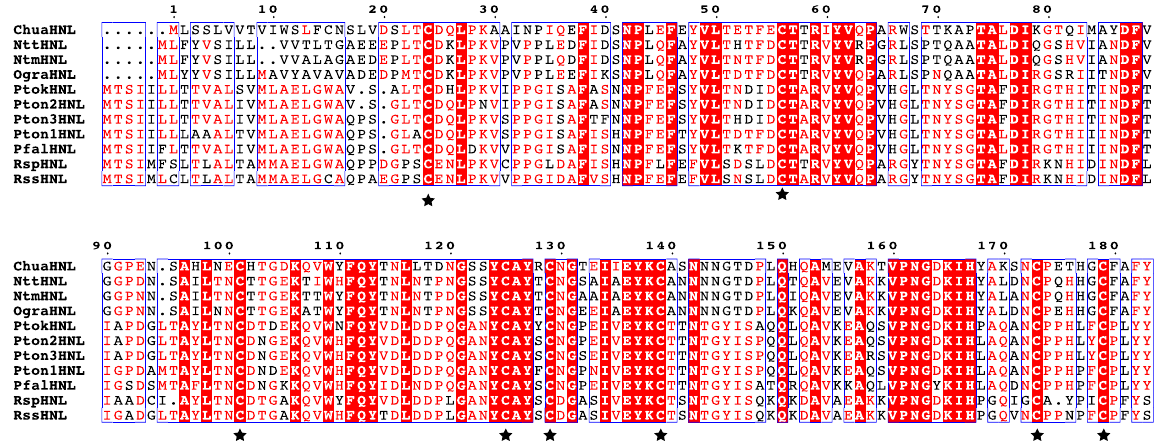
Figure 2. Amino acid sequence alignment of HNLs from millipedes. Multiple sequence alignment was visualized by ESPript 3 (http://espript.ibcp.fr/ESPript/ESPript/). Red background shows strictly conserved residues; red letters indicate residues well conserved within a group according to a Raisler matrix; and remainder are shown in black. Residues conserved between groups are boxed. Stars indicate Cys residues conserved among millipede HNLs.